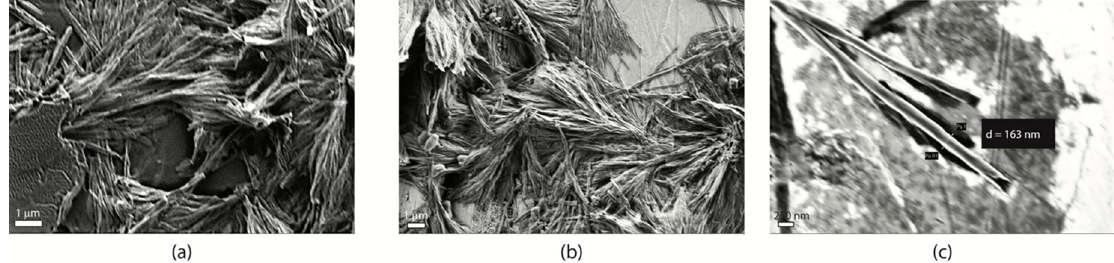
Figure 4. SEM topographies of precipitates from equilibrium solutions of ( D )ZnP(-) ( a ) and ( L )ZnP(-) 10 μ M ( b , c ) in the presence of ( R )-1-phenylethanamine. Images obtained with ( S )-1-phenylethanamine are reported in Figure S5 of Supplementary information.